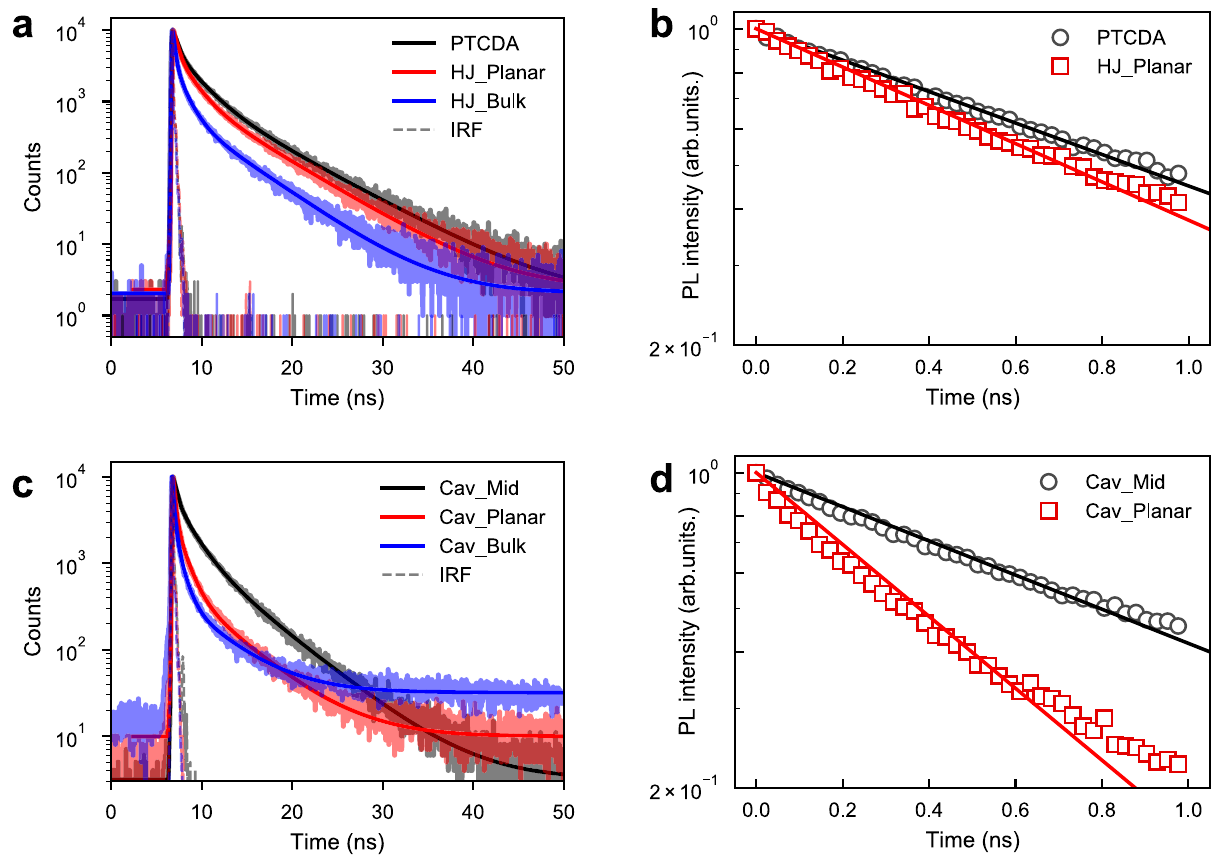
Fig. 3 Time-resolved emission from HJ fi lms and cavities. Time-resolved PL decay (shadow line) of fi lms ( a ) and cavities ( c ) excited at 475 nm and probed at the emission position of PTCDA (720 nm), together with fi tting to a three-exponential model (solid line). b , d The PL decays (scatter marker) and corresponding fi ttings (solid line) based on a rate-based model describing the dynamics of the energy relaxation in the systems.